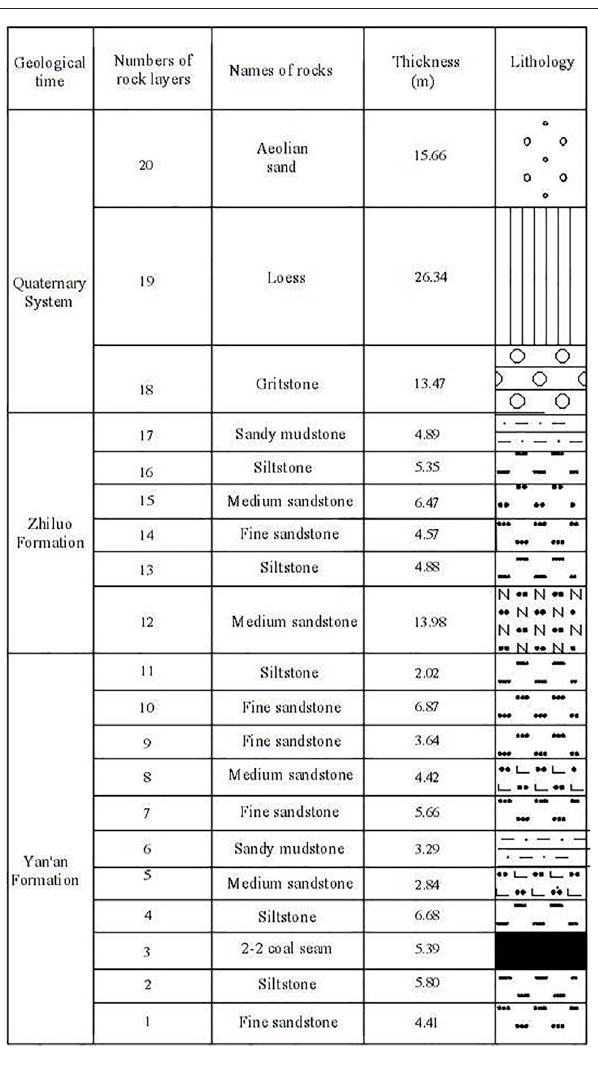
FIGURE 2 | The borehole log of working face 22407.